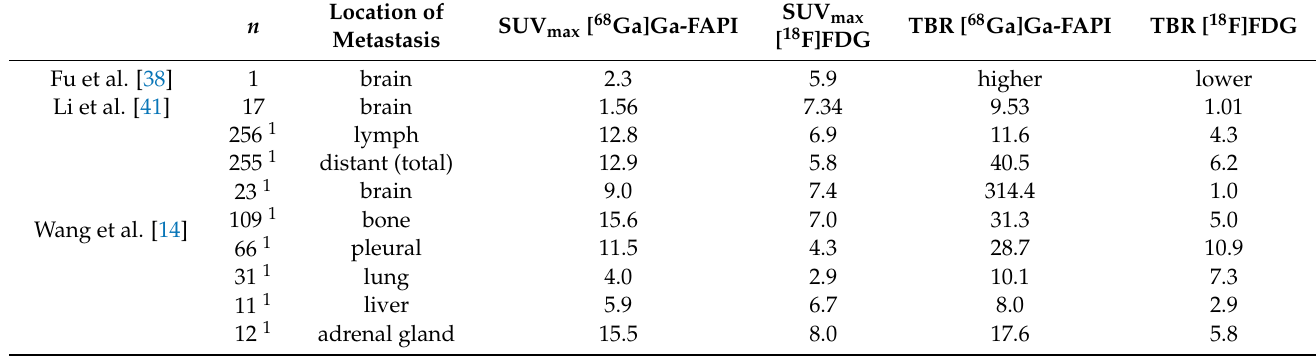
Table 2. Overview of SUV max and TBR of [ 68 Ga]Ga-FAPI and [ 18 F]FDG reported for lung cancer